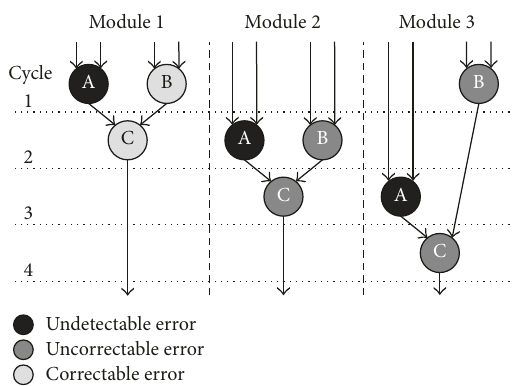
Figure 1: An example binding onto three color-coded resources. For this binding, a single fault can result in an undetectable, uncorrectable (but detectable), or correctable error, depending on the